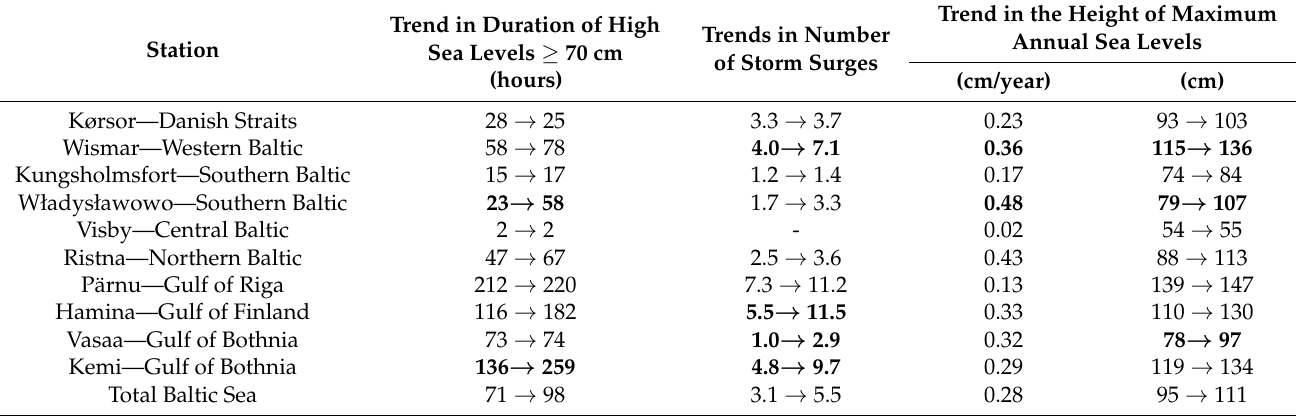
Table 3. Trends in duration of high sea levels ≥ 70 cm per year and in the number of storm surges per year, along with trends in the maximum annual sea level values determined from the trend line for the Baltic Sea tide gauging stations at the beginning and at the end of the 1960–2020 period